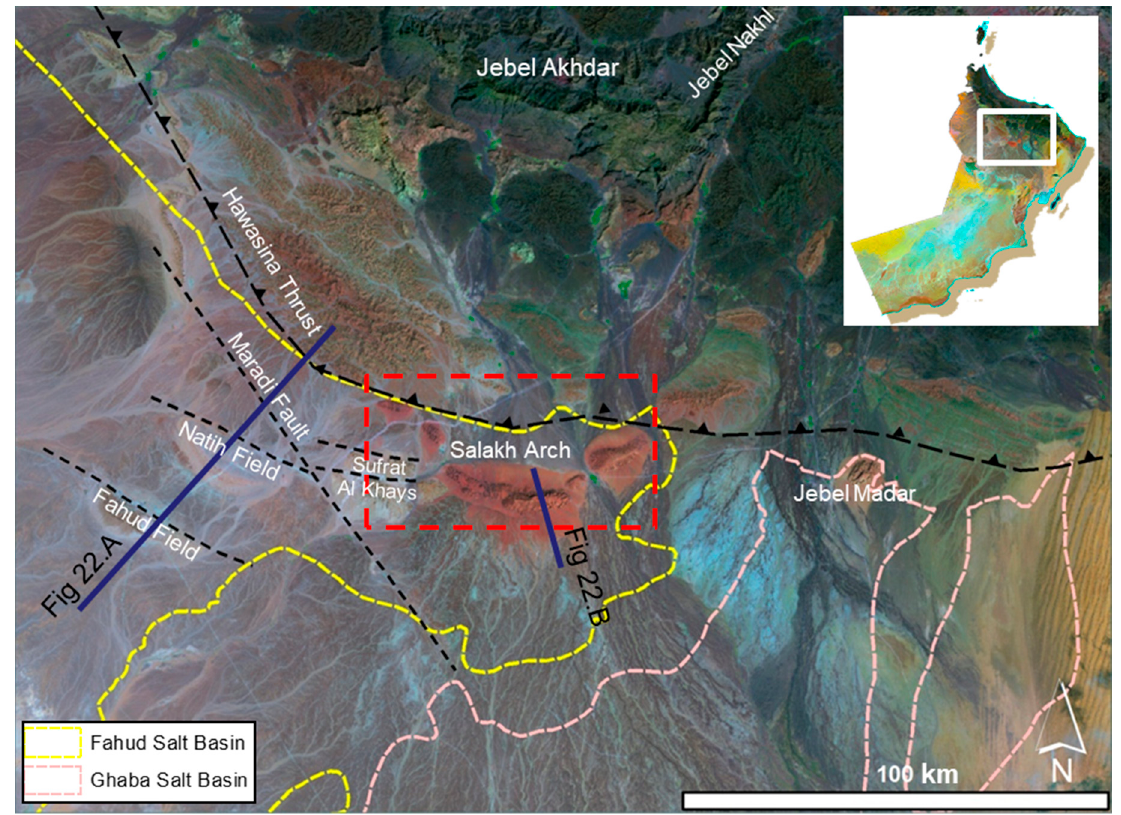
Figure 1. A LANDSAT image showing the position of the Salakh Arch on the eastern side of the Fahud Salt Basin (dashed yellow line). The arch formed S of the most advanced part of the Hawasina nappes, and NE of the Maradi Fault System. The red dashed line shows the location of the geological map in Figure 2. The oil fields of Natih and Fahud are both bounded by major faults. Geosciences 2020 , 10 , 95